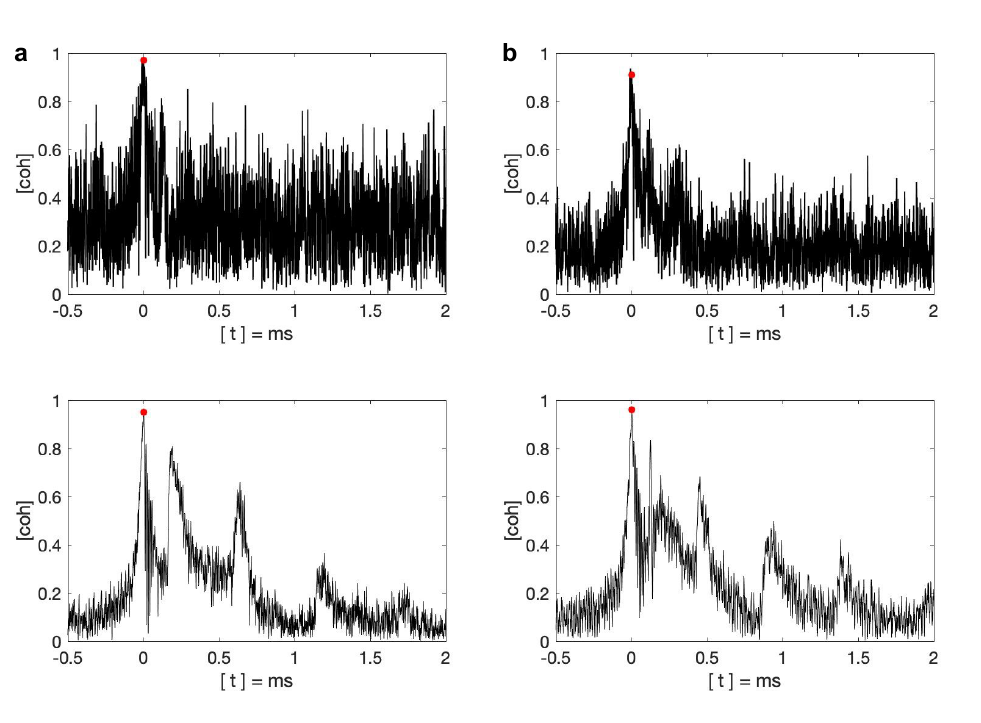
Figure 10. ( a ) Coherency waveforms used in the simulation with a small network ( N = 10). ( b ) Coherency waveforms used in the simulation with a small network ( N = 20). For both Fig- ures ( a , b ), the upper figure is the calculated coherency waveform and the bottom figure is the coherency waveform of 270 km and 410 km, respectively, from the coherency waveform bank. In all the figures, the ground wave maxima are marked with red